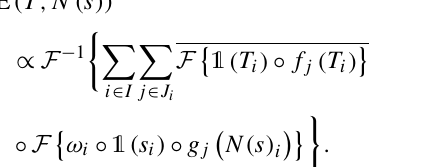
Figure 2. Illustration of the k -sampling